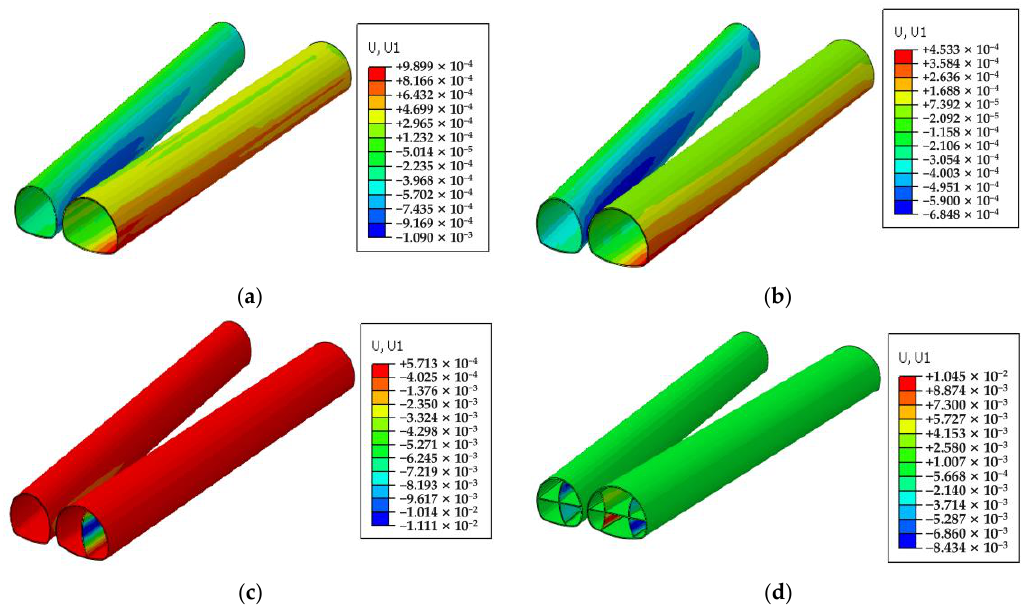
Figure 8. Horizontal displacement of the lining (unit: m): ( a ) Step method; ( b ) Full section method; ( c ) CD method; ( d ) Double wall heading method.